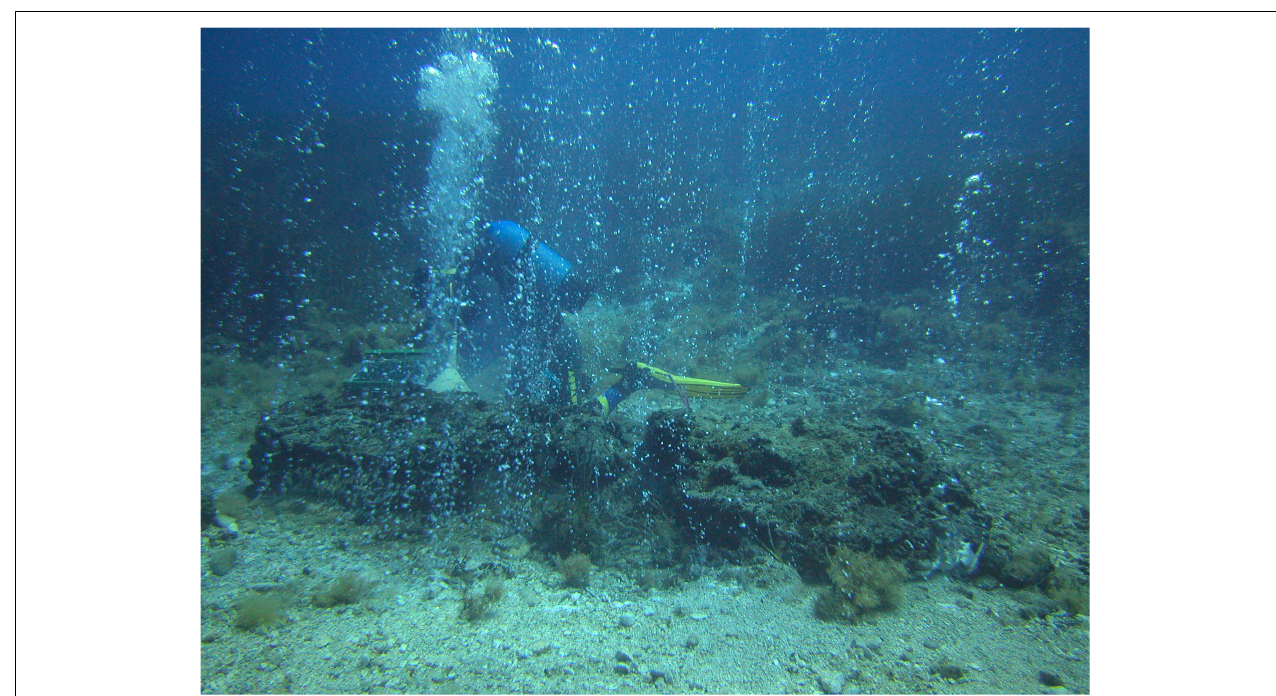
FIGURE 3 | Underwater gas emission and mineral deposition outcrop in an underwater vent in